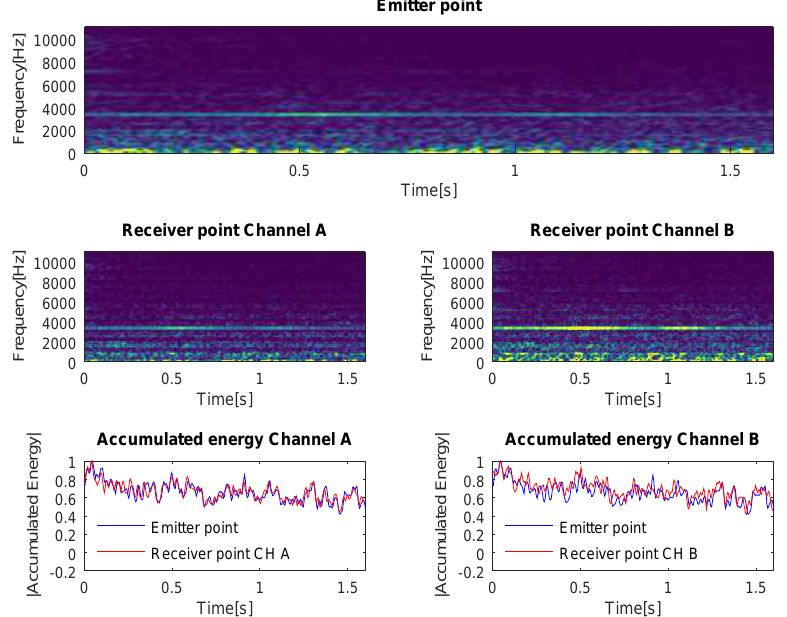
Figure 2. Anomalous noise event labeled as a bell. The spectrogram of the emitted signal in the upper plot; in the mid-left plot, the spectrogram of the received signal through Channel A; in the mid-right plot, the spectrogram of the received signal through Channel B; in the lower-left plot, the accumulated energy through Channel A; and in the lower-right plot, the accumulated energy through Channel